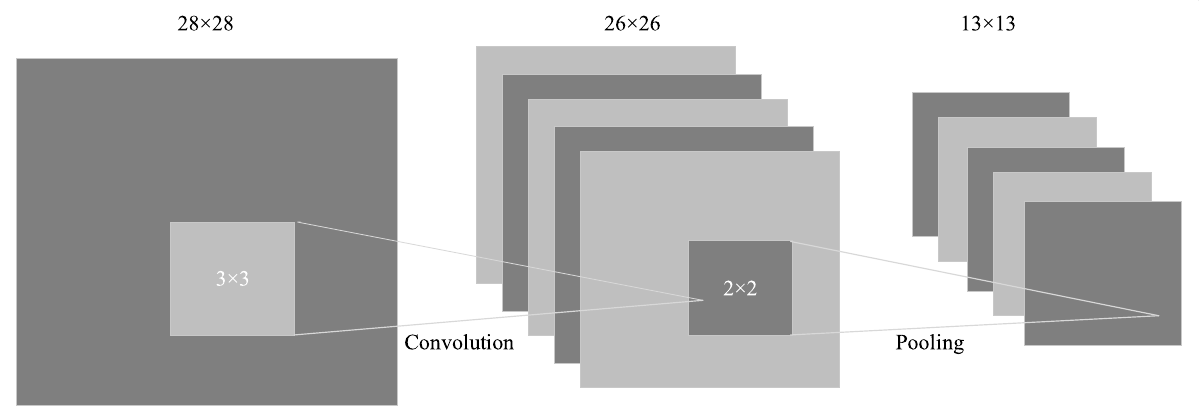
Fig. 2 The process of convolution and pooling in the image CNN